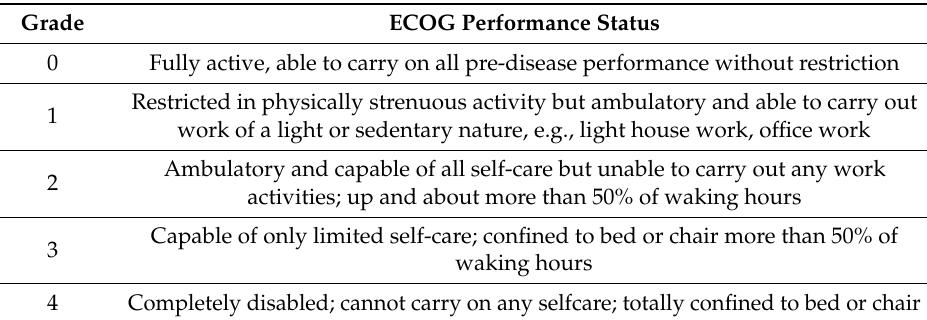
Table 4. ECOG performance status (adapted from Oken et al.)